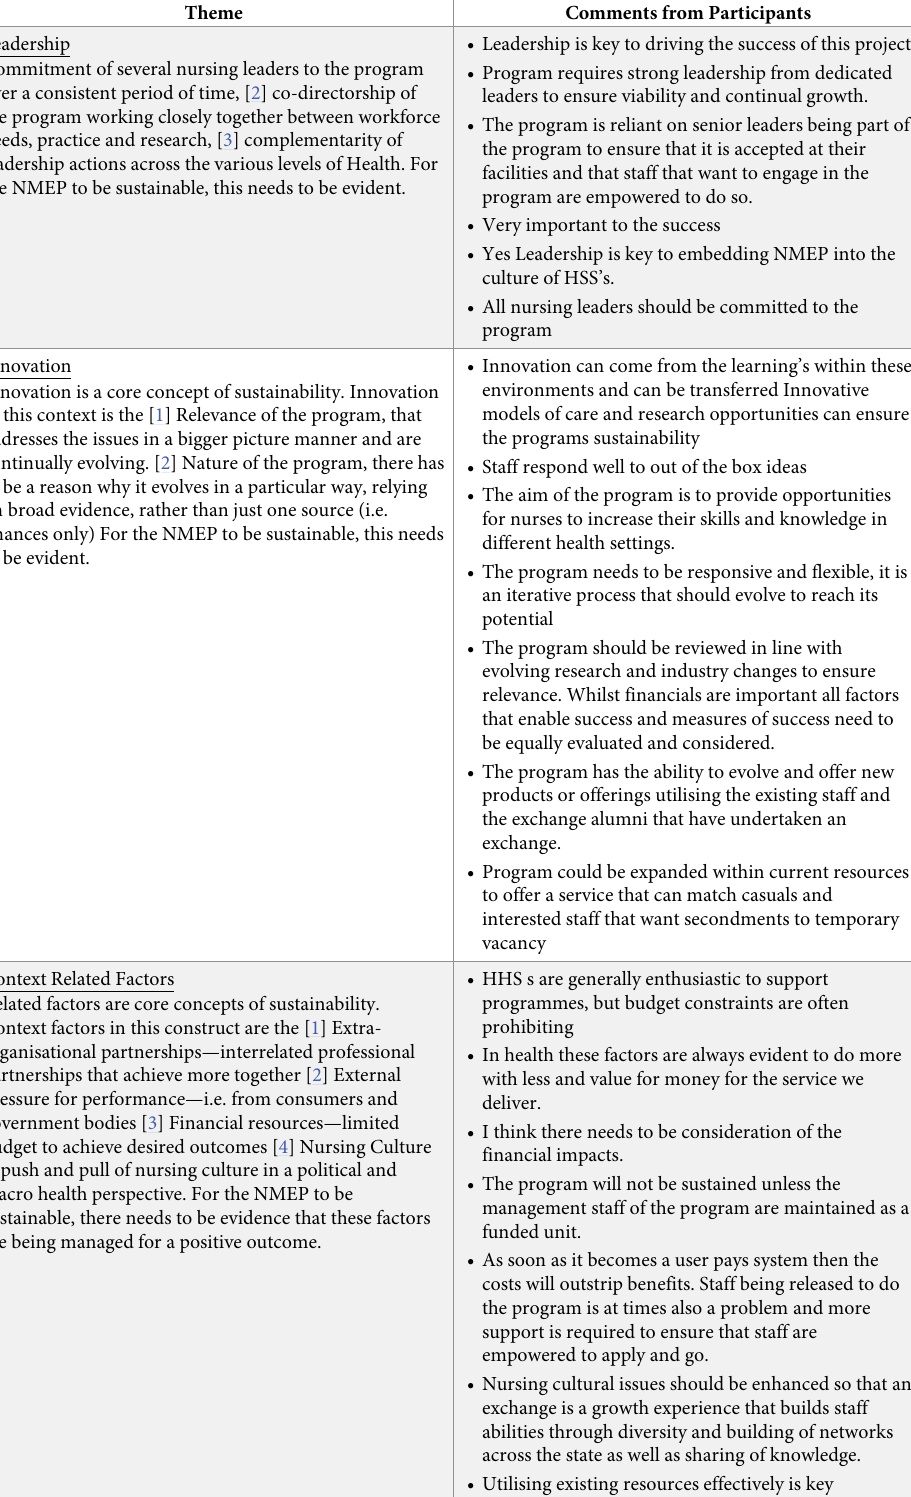
Table 8. Narrative from open-ended